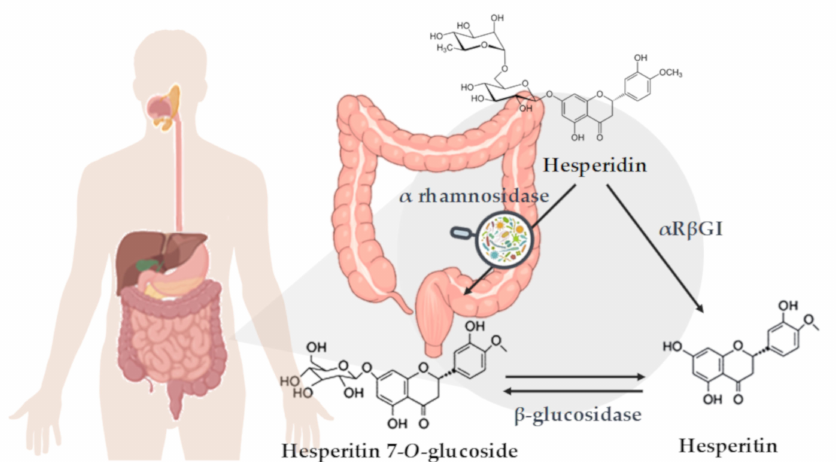
Figure1. Schematicrepresentationofhesperidinmetabolizationinthecolon. Enzymaticdeglycosylation of hesperidin to yield hesperetin: via hesperetin-7-O-glucoside by two specific monoglycosidases, α -rhamnosidase and β -glucosidase, and via one-step deglycosylation through α -rhamnosyl- β - glucosidase ( α R β